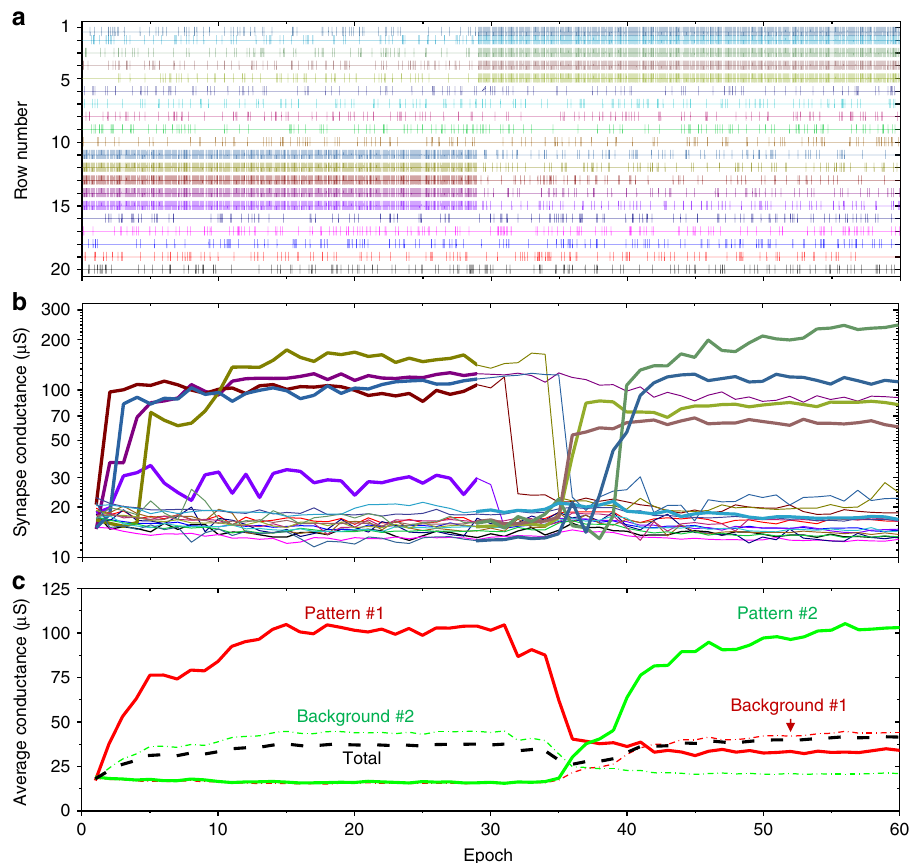
Fig. 5 Coincidence detection of two lower-noise patterns. a A spiking input with p spike = 0.2, ( t jitter ) max = 5 ms, ( Δ offset ) max = 500 ms. The fi rst pattern of synchronous spikes was applied to the rows #11 through #15 in the fi rst 30 epochs, while the second pattern was applied to rows #1 through #5 in the last 30 epochs. b Time evolution of all devices ’ conductances involved in the experiment. c Post-processed results from panel b , showing time evolution of the total and the averaged conductances for all devices and the averages of subsets corresponding to the synchronized (pattern #1 and pattern #2) and noise inputs. The colour coding in panels a and b are similar to those of Fig. 4